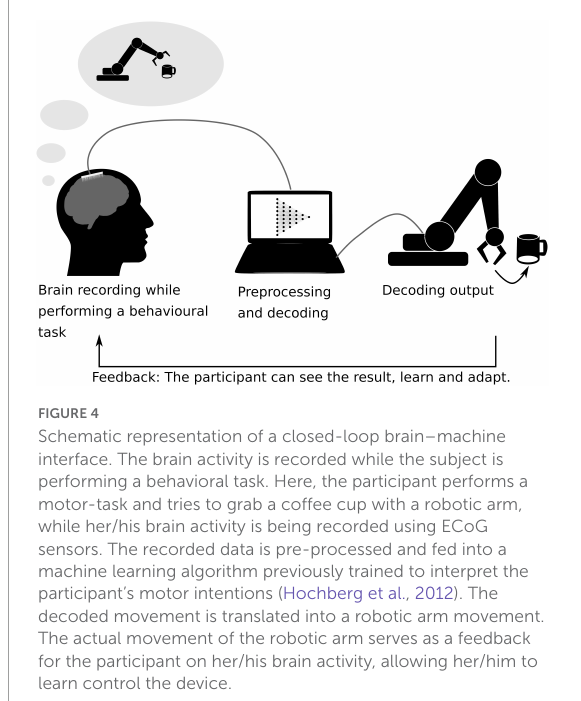
FIGURE4 Schematic representation of a closed-loop brain–machine interface. The brain activity is recorded while the subject is performing a behavioral task. Here, the participant performs a motor-task and tries to grab a coffee cup with a robotic arm, while her/his brain activity is being recorded using ECoG sensors. The recorded data is pre-processed and fed into a machine learning algorithm previously trained to interpret the participant’s motor intentions (Hochberg et al., 2012). The decoded movement is translated into a robotic arm movement. The actual movement of the robotic arm serves as a feedback for the participant on her/his brain activity, allowing her/him to learn control the